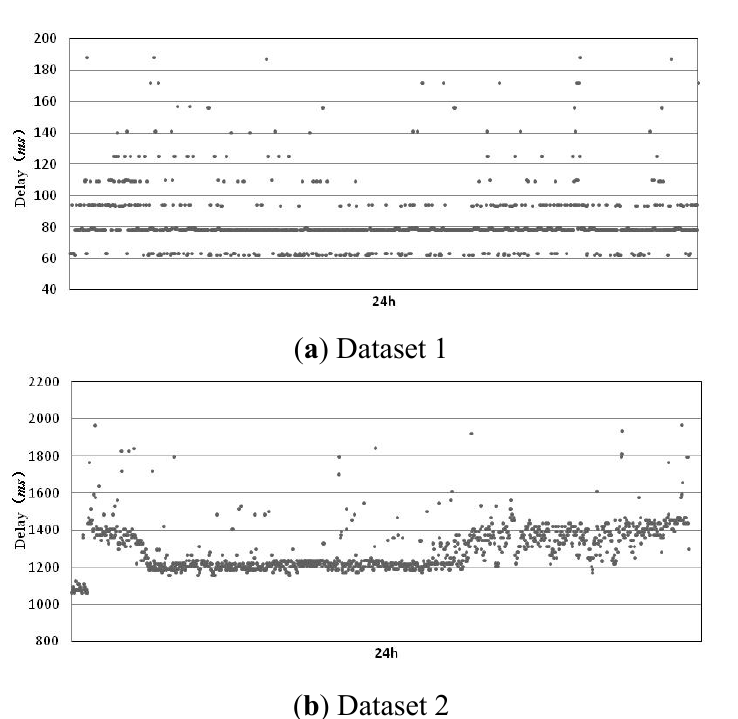
Figure 2. Experimental results for transmission